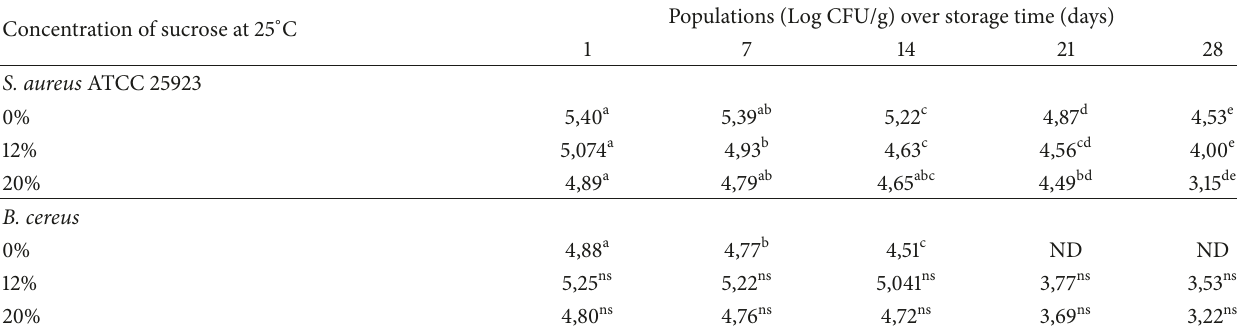
Table 5: Populations of S. aureus ATCC 25923 and B. cereus in almond butter at varying concentrations of sucrose stored at 25 ∘ C. Concentration of sucrose at 25 ∘